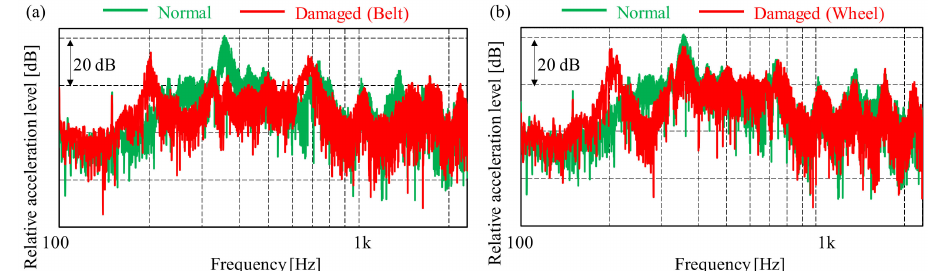
Figure 15. Comparison of the frequency characteristics of the vibration in the normal condition and each of two damage conditions: damaged belt and damaged guide wheel. ( a ) The frequency characteristics of the peaks and dips when operating in the normal condition di ff er from those associated with operating with a damaged belt. ( b ) Shown are some di ff erences between operating in the normal condition and operating with a damaged guide wheel.